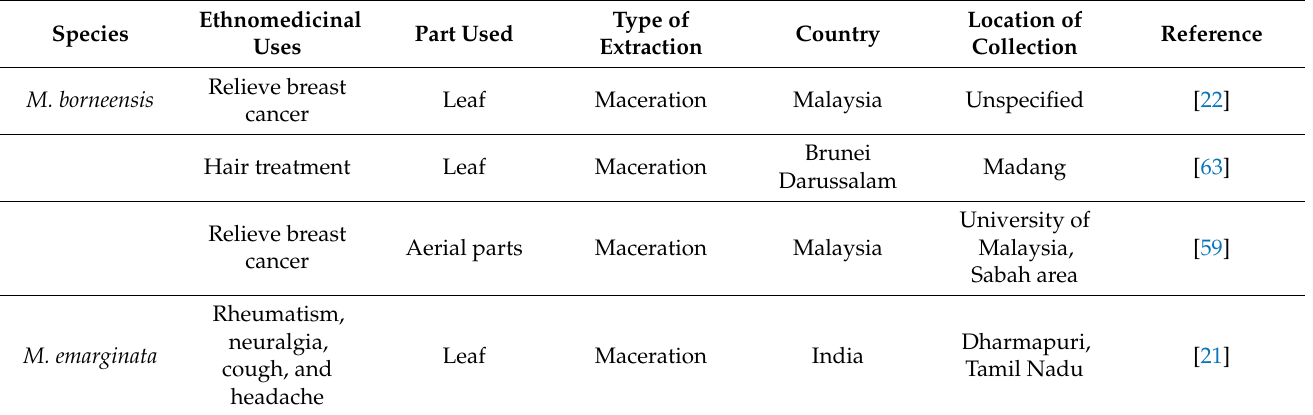
Table 4. Ethnomedicinal uses of Merremia